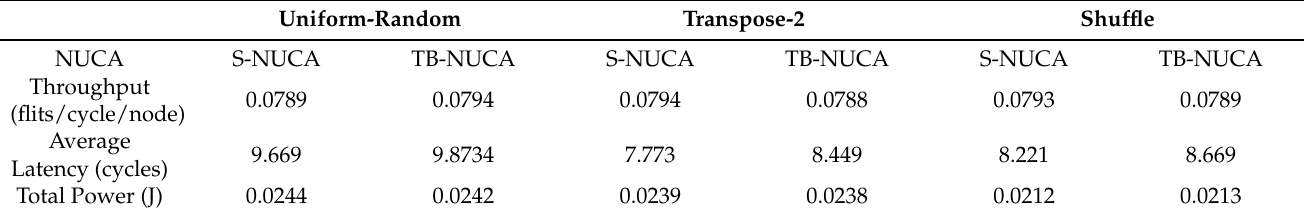
Table 3. Throughput comparison under different conditions for TB-NUCA and S-NUCA.